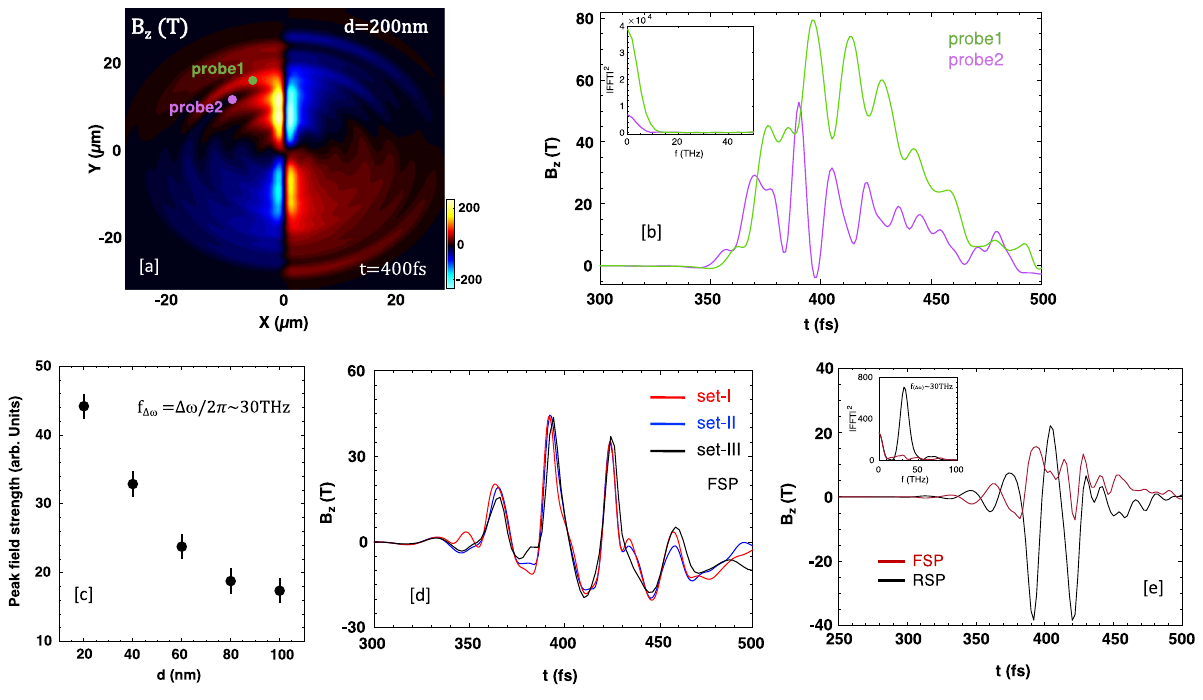
400 fs for target thickness Figure 4. ( a ) Snapshot of spatial distribution of filtered magnetic field B z ( T ) at t = 15 µ m ) and 200 nm . ( b ) Temporal profiles of emitted radiation measured by; probe1( x = 5 µ m , y d = = − 10 µ m ). ( c ) Peak field strength of beat-frequency radiation as a function of plasma 10 µ m , y probe2 ( x = = − 10 µ m , sheet thickness. ( d ) Temporal profiles of emitted radiation measured by the front-side probe ( x = − 10 µ m ) for three different sets; set-I ( d 5 n 10 n 20 nm , n 10 nm , n y e 0 = c ), set-II ( d = e 0 = c ), and set- = = 50 n 2 nm , n III ( d e 0 = c ) from a preloaded plasma sheet target. ( e ) Temporal profiles of filtered radiation = fields (measured by the front-side and rear-side probes located 10 µ m away from the emission spot) from an unionized target, like a graphene sheet, and their corresponding power